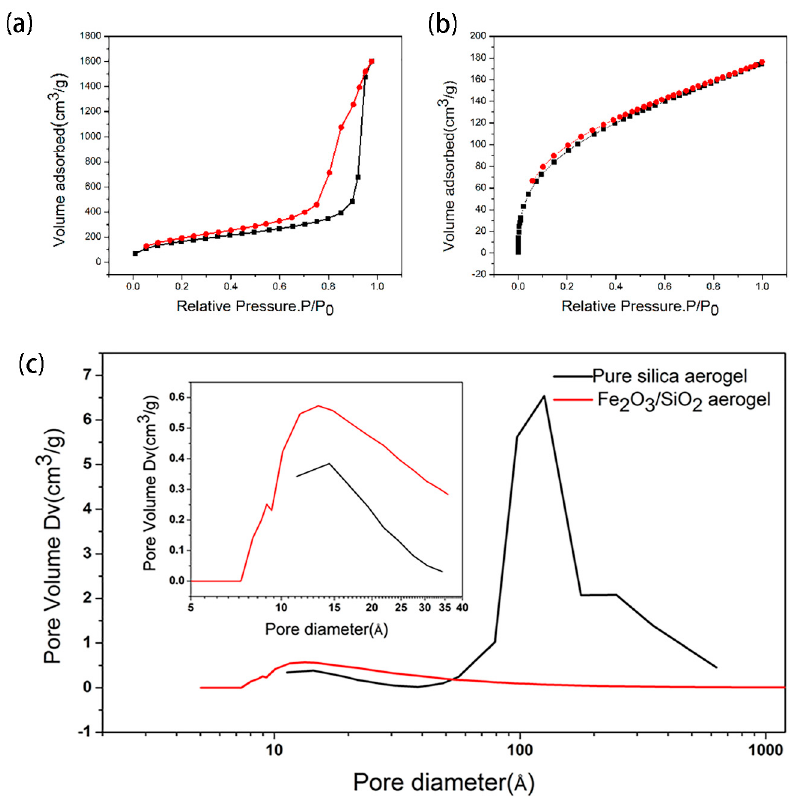
Figure 3. The N 2 adsorption-desorption isotherms of: ( a ) Pure silica aerogel and ( b ) Fe 2 O 3 /SiO 2 aerogel, and ( c ) the pore size distribution of pure silica aerogel and Fe 2 O 3 /SiO 2 aerogel; a comparison of microporous distribution of pure silica aerogel and doped aerogel is inset.